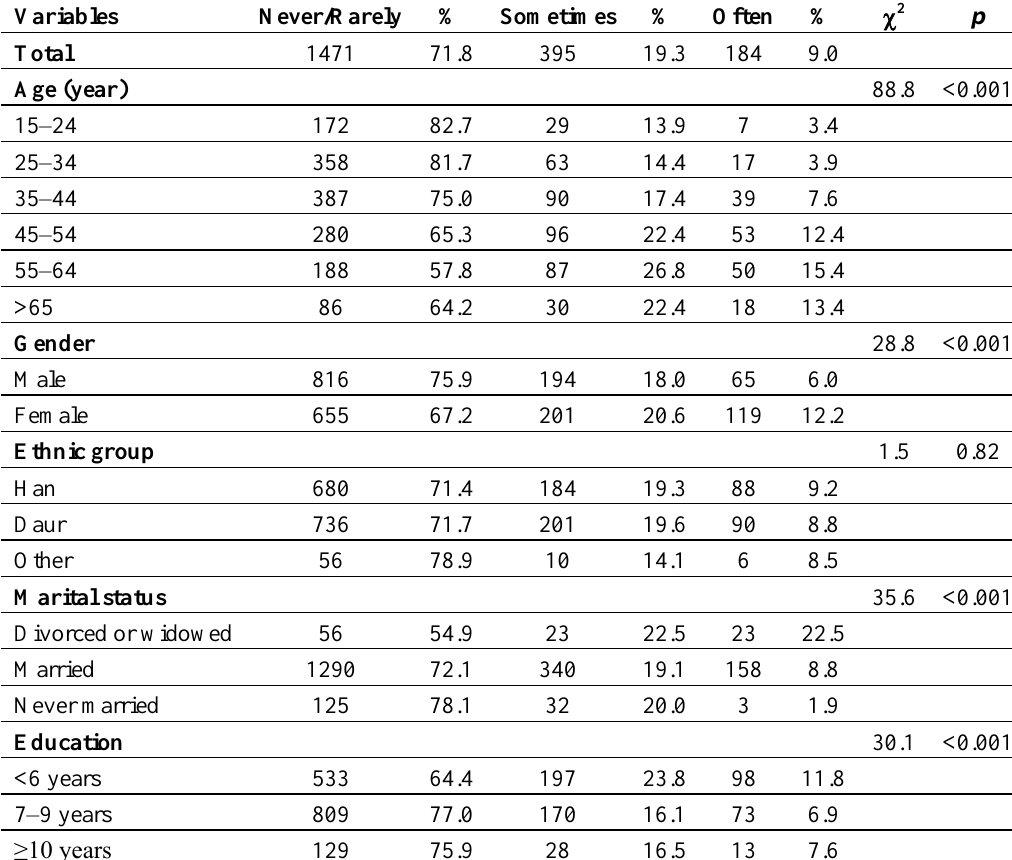
Table 2. Self-reported difficulty falling asleep at night by farmers in a northeastern province, China.